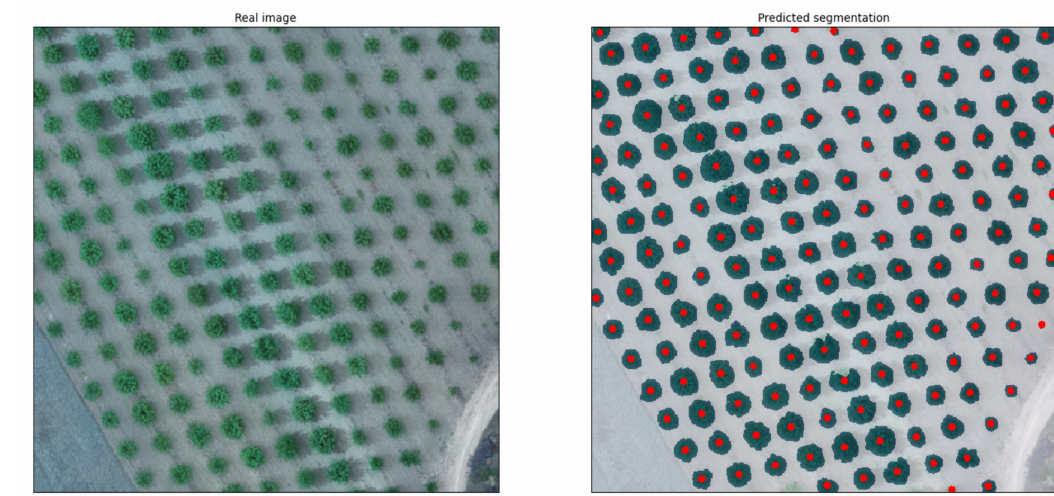
Figure 8. Undersampled orthomosaic of an orchard with large- to medium-sized canopies ( left ) and the segmentation predicted by the model ( right ).